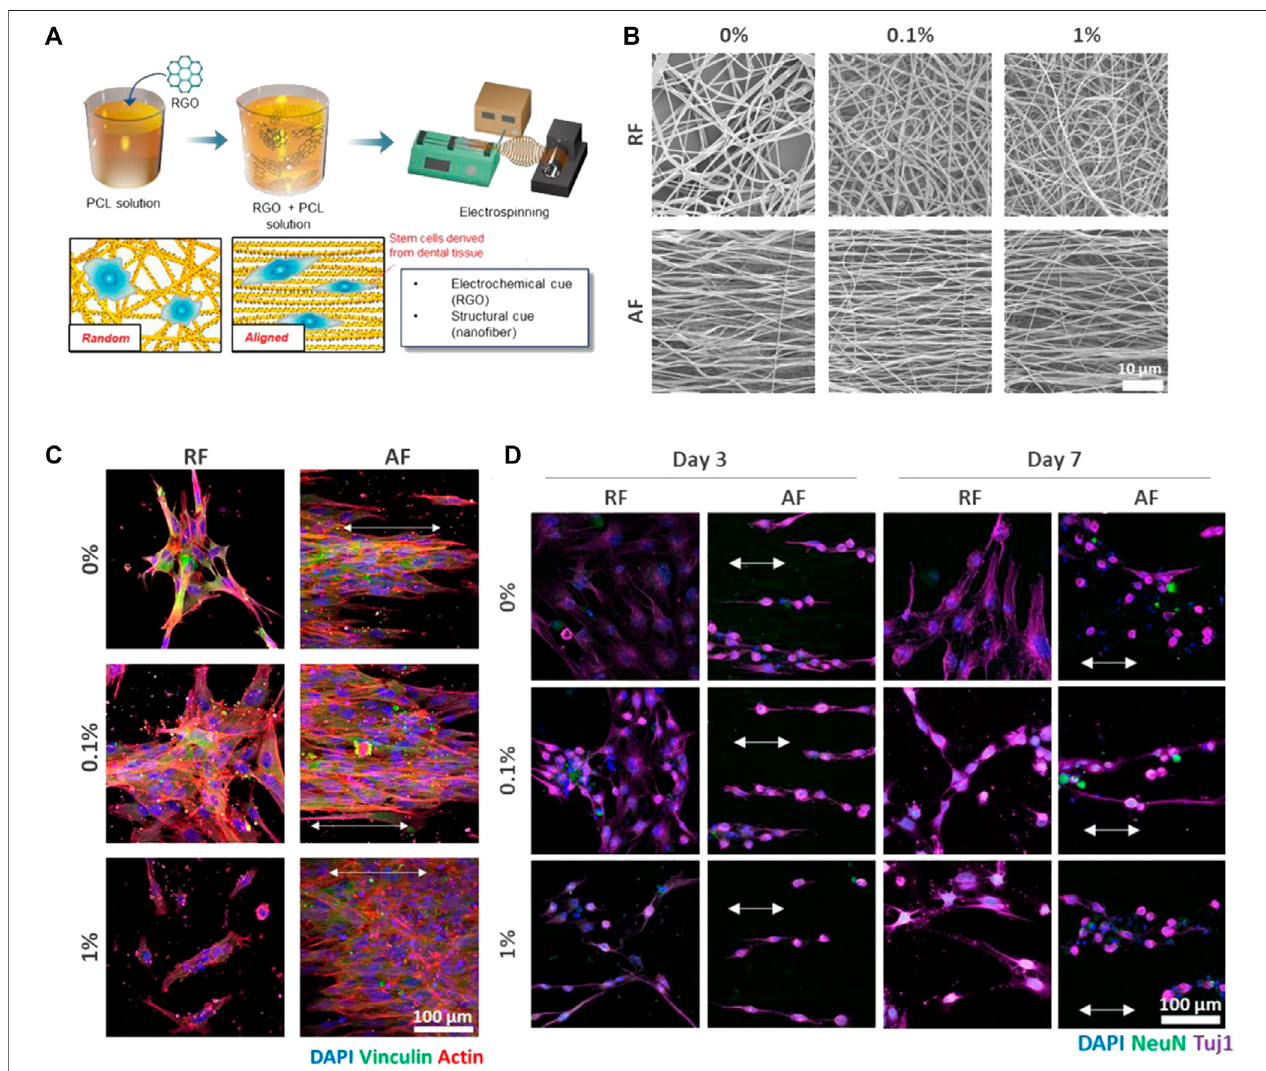
FIGURE 7 | (A) The preparation procedure of the rGO/PCL nano fi bers and schematic of DPSCs-nano fi ber interactions depending on the nano fi bers ’ alignment mode. (B) SEM images show the morphology and alignment of the rGO/PCL nano fi bers at different rGO concentrations. (C) The immunocytochemistry images taken after 48 hseeding ofthe cellsalongsidethe rGO/PCLnano fi bers imply theinterplaybetweenthe nano fi ber alignmentand thecells ’ shape. Noteworthy,the cellspresent on the nano fi bers containing the highest rGO fi lling factor (1%), were not stained with vinculin, which represents focal adhesion. This indicates poor cell adhesion probablyduetotheadverseeffectofrGOathighamounts. (D) TheimmunocytochemistryimagesimplytheneurogenicdifferentiationofDPSCsinducedbytherGO/PCL nano fi